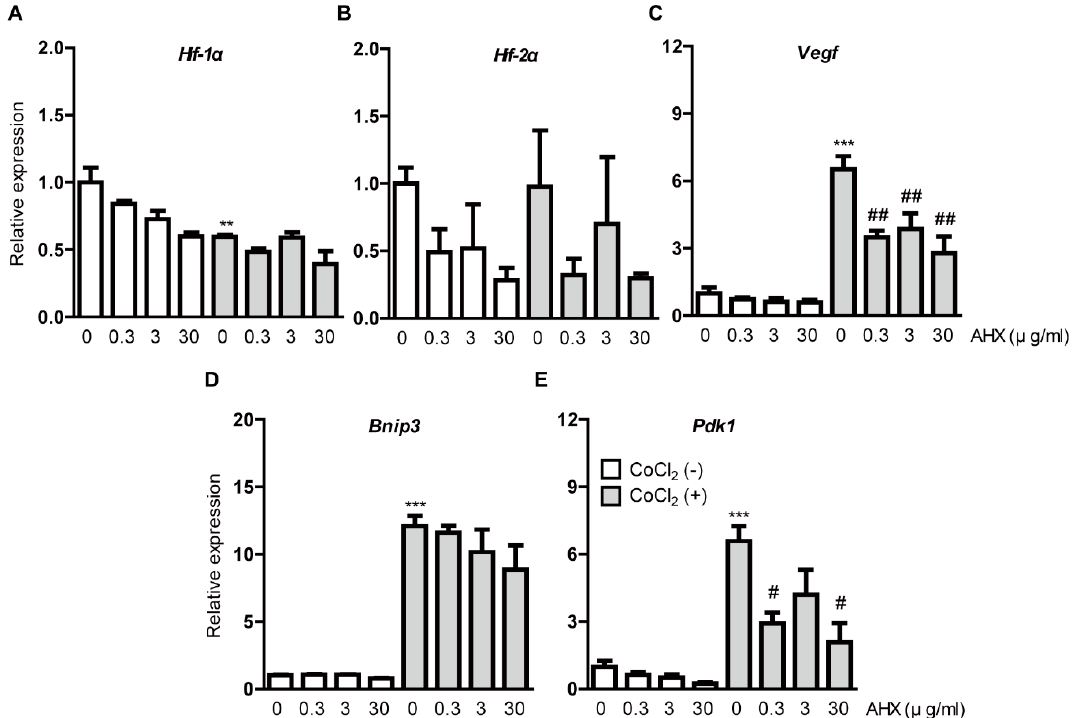
Figure 3. Suppression of hypoxia-responsive gene expressions by AHX treatment. Relative fold changes in ( A ) Hif-1 α , ( B ) Hif-2 α , ( C ) Vegf , ( D ) Bnip3 and ( E ) Pdk1 mRNA expressions were shown